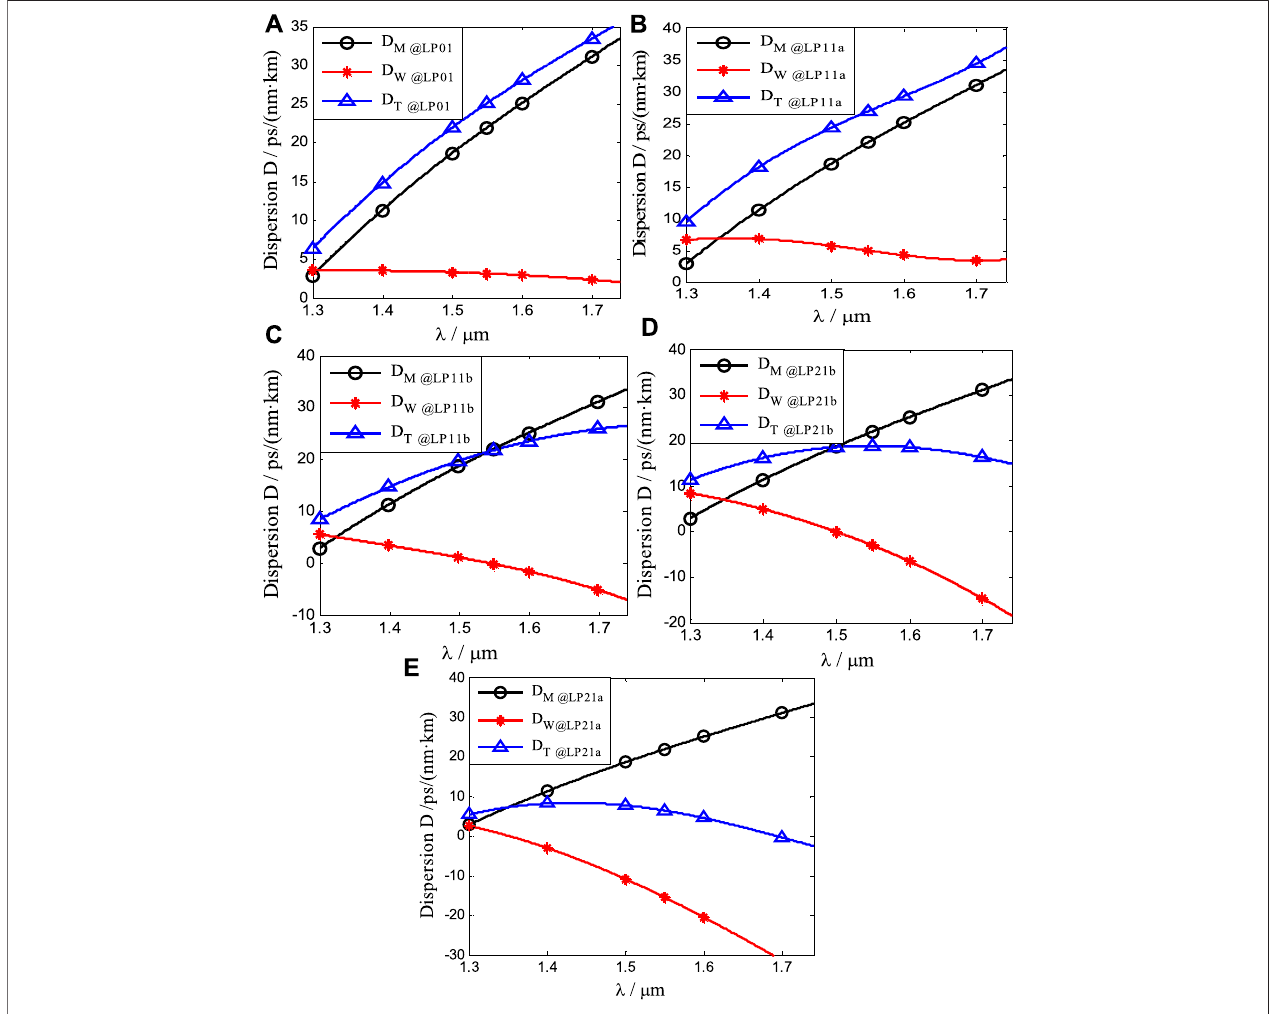
FIGURE5| Dispersions ofthemodes LP01 (A) ,LP11a (B) ,LP11b (C) ,LP21b (D) ,andLP21a (E) varywiththeinputwavelength.Thesolidlineswithcircles,stars, and triangles represent the material dispersion D M , waveguide dispersion D W , and total dispersion D T of each mode.